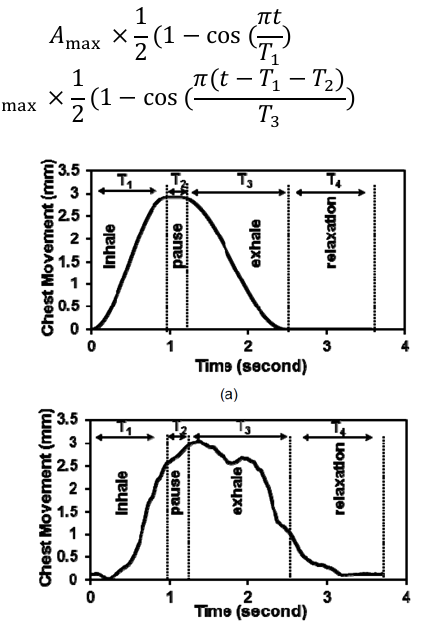
Figure 2: chest wall motion a) modeled b) measured [17]